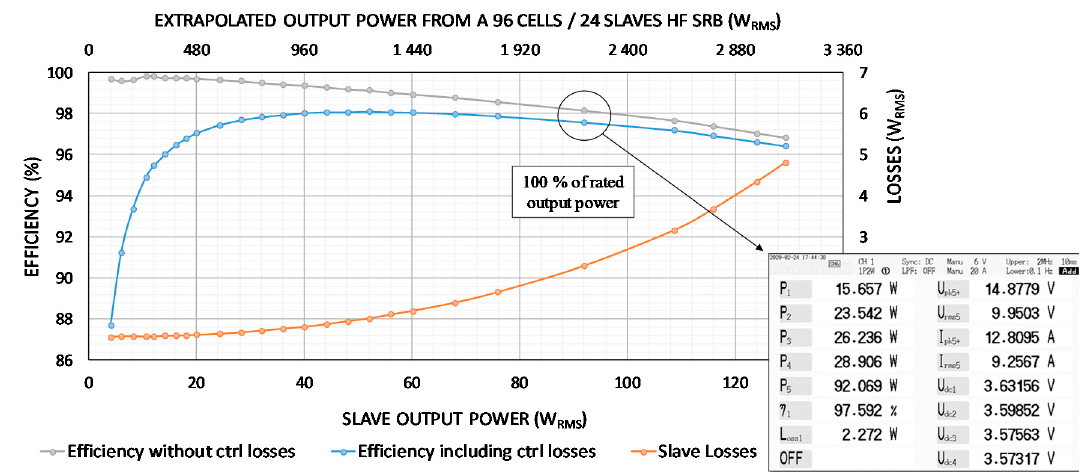
Figure 10. Slave HF SRB discharge efficiency over 50 Hz staircase-shaped sine waveform.